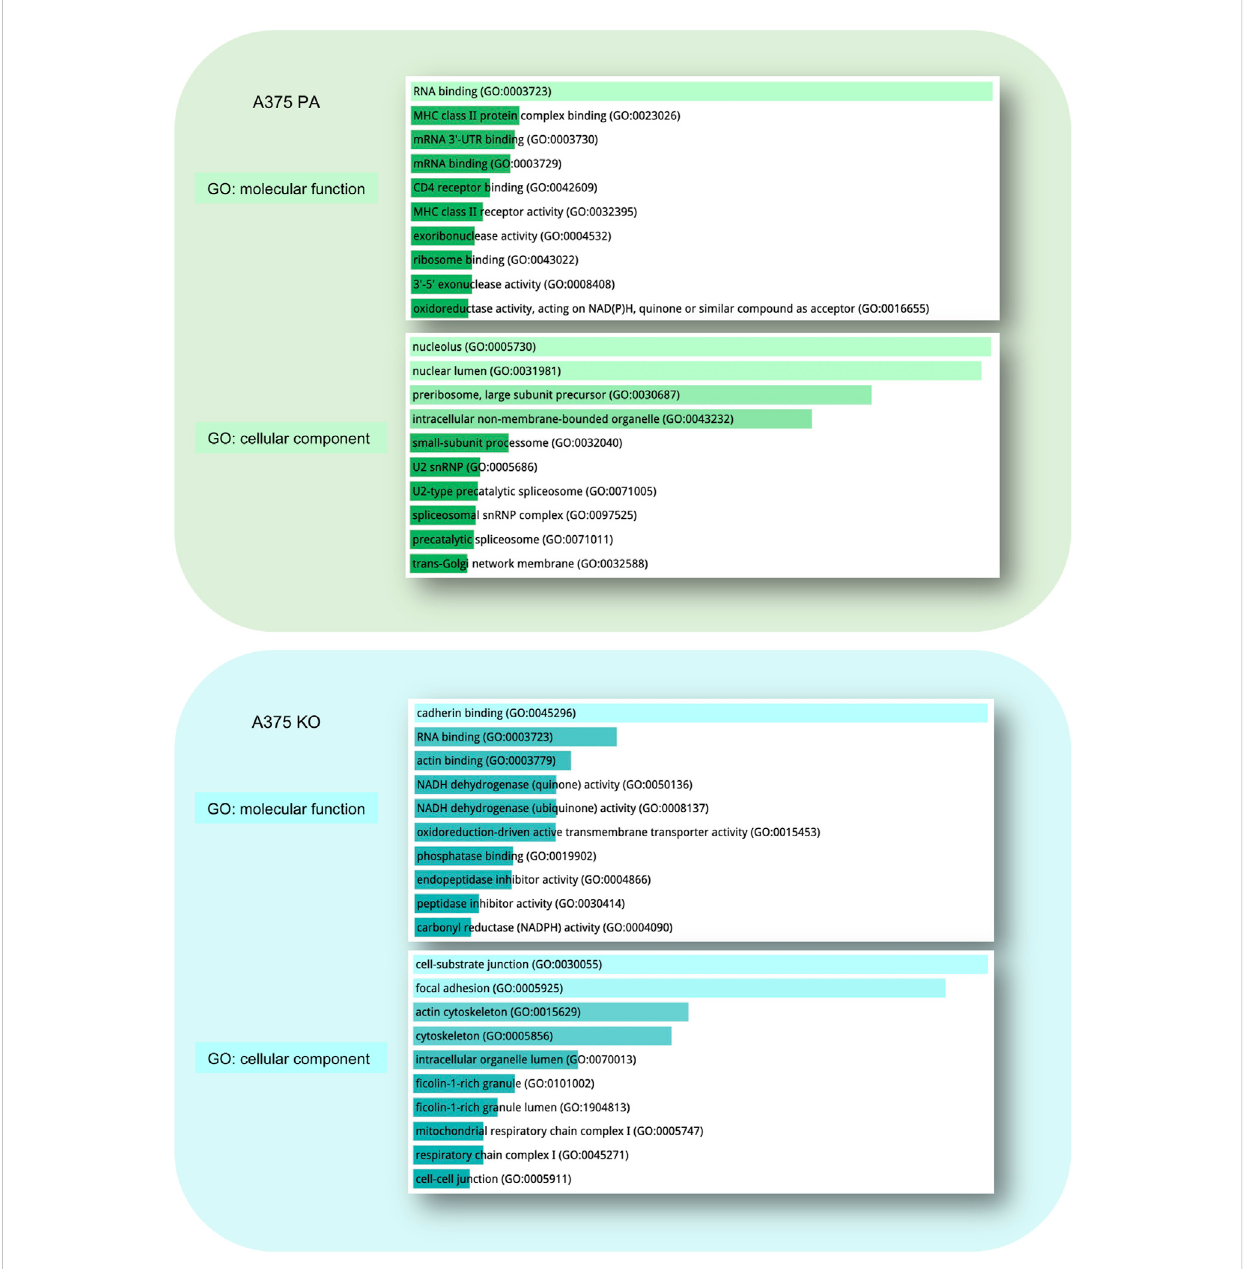
FIGURE 4 STRING analysis showing the signi fi cantly upregulated functional and physical interaction protein networks in the A375 parental and A375 YB-1 knock-out cell lines. Red arrows point to proteins that were stained with immunolabelling. The background coloring in A375 parental cell line highlights the clustering within the network. Halo color represents the effect size. The disconnected nodes were removed. Abbreviations: PA — parental; KO —